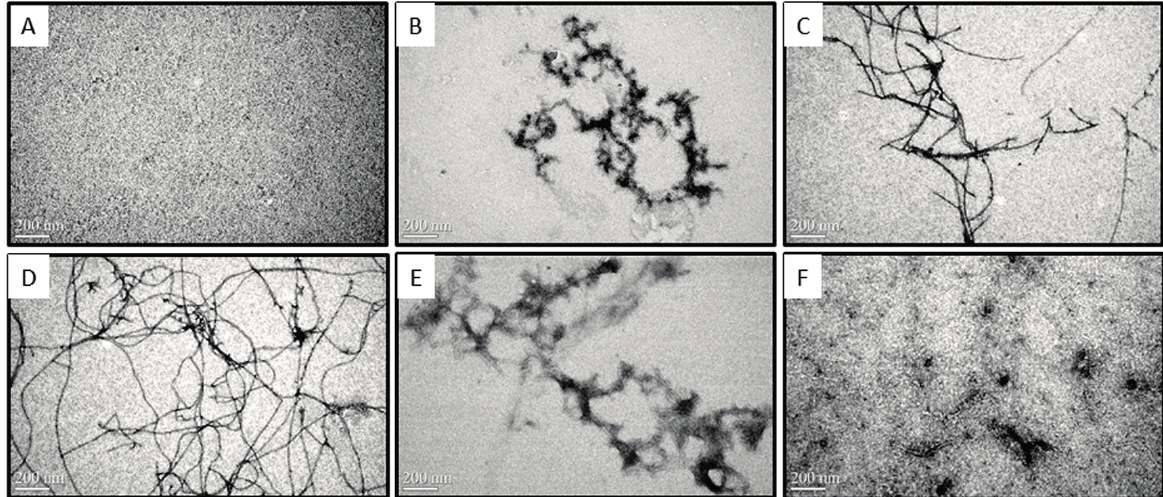
Figure 2. Effect of COS on A β aggregates visualized by Transmission Electron Microscopy (TEM). Representative TEM images of monomeric A β 42 fractions soon after preparation ( A ) and fibrils formed by monomeric A β 42 after 12 h ( B ), 24 h ( C ), and 48 h ( D ) of incubation at 37 °C (10 μ M A β 42, without agitation); Representative images of monomeric A β 42 (10 μ M) coincubated with 0.5 mg/mL ( E ) or 1.0 mg/mL COS ( F )